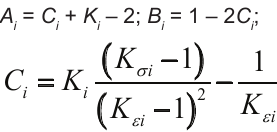
A = C + K – 2; B = 1 – 2 C i i i i